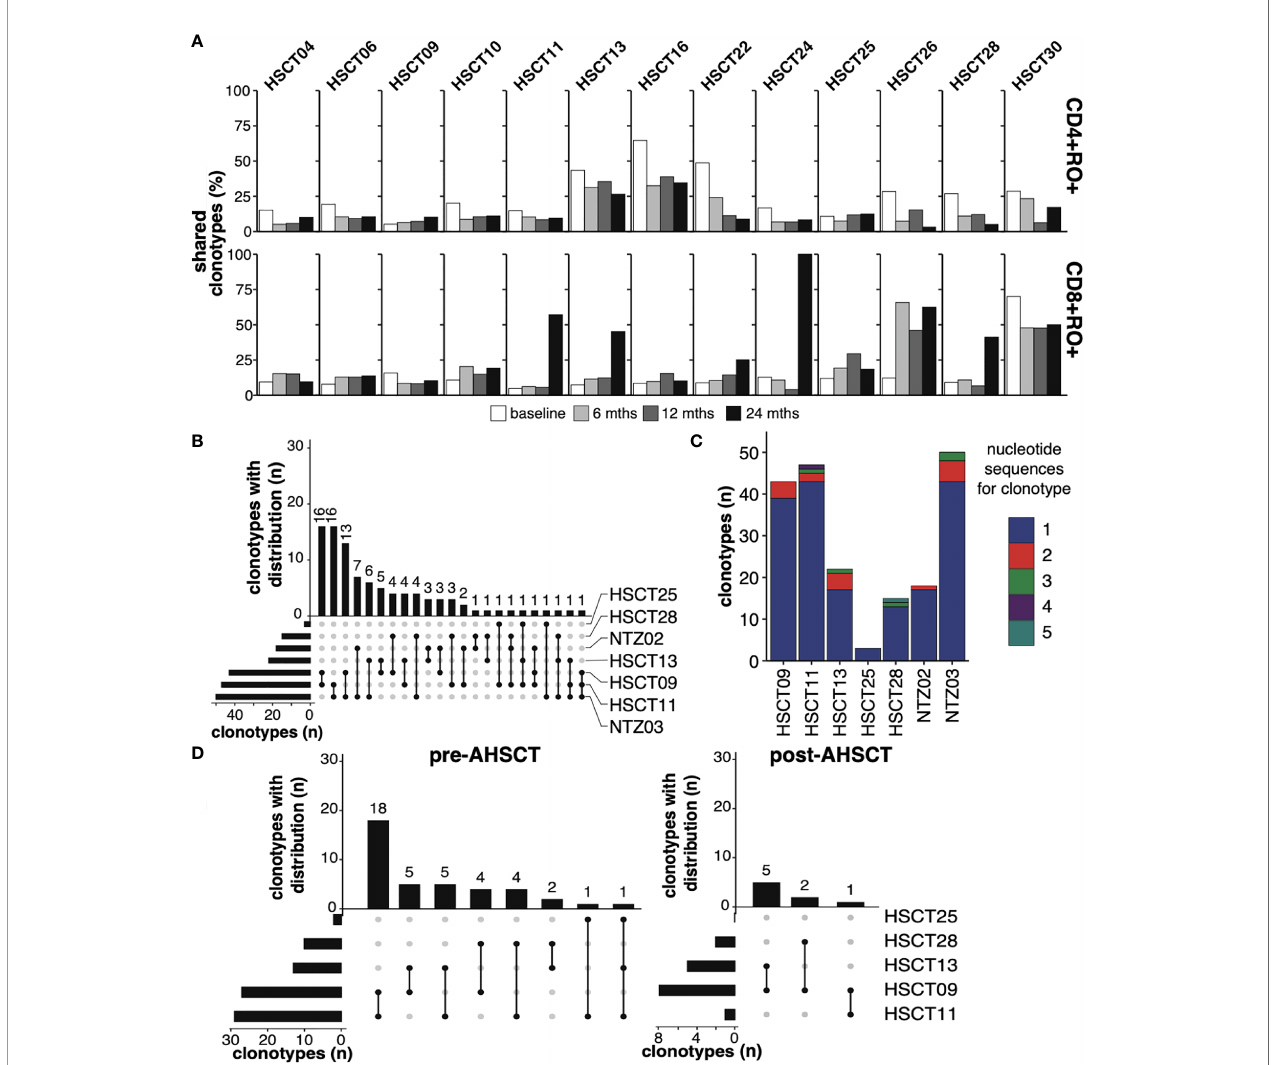
FIGURE 3 | Public T-cell clones (A) The fraction of public T-cell clonotypes within CD4+CD45RO+ [top panel] and CD8+CD45RO+ [bottom panel] of each individual (top x-axis, each horizontal subsection) undergoing AHSCT at baseline (0, white), 6 (light grey), 12 (dark grey) and 24 months (black, bottom x-axis). (B) Upset plot depicting patterns of sharing of public CD4+CD45RO+ clones (minimum 2 reads in each individual) amongst the 7 HLA DRB1*15:01 positive patients at baseline, ranked by the number of clonotypes shared between *1501-positive individuals. The vertical bars, ‘ clonotypes with distribution ’ , represent the number of clones (not clone size) shared between the individuals linked in the dots below each bar. The horizontal bars to the lower left depict the number of public clones within each individual ’ s repertoire, ranked from least number of public clones to most. (C) The number of public clones within each individual depicted by different nucleotide reads, 1 to 5 (maximum) e.g. within HSCT09, 39 public clones were identi fi ed, each encoded by a different nucleotide sequence, whilst 4 clones were identi fi ed that were each encoded by two different nucleotide sequences. 12% of public clones in (6 of the 7) *15:01-positive individuals are encoded by differing nucleotide sequences. (D) Upset plots depicting patterns of sharing of public CD4+CD45RO+ clones (minimum 2 reads in each individual) amongst 5 HLA DRB1*15:01- positive patients undergoing AHSCT at baseline and at 24 months, ranked by the number of clonotypes shared between individuals. No shared clones were identi fi ed in HSCT25